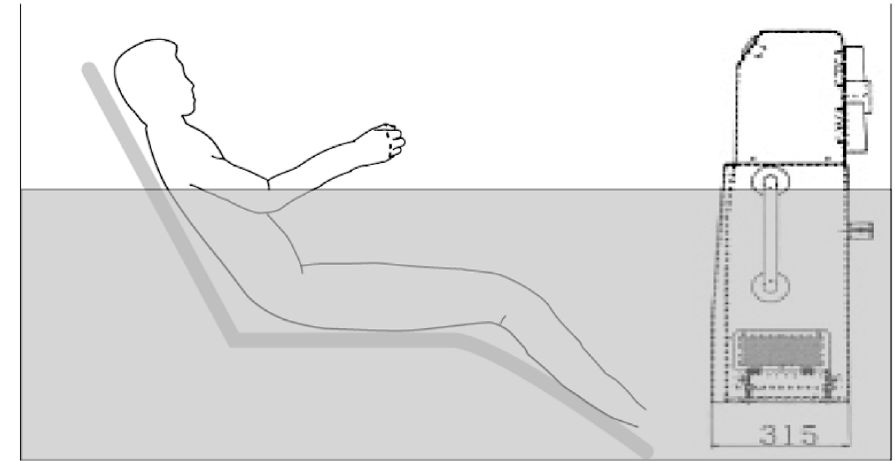
Figure 2. The experimental setup of the present study.